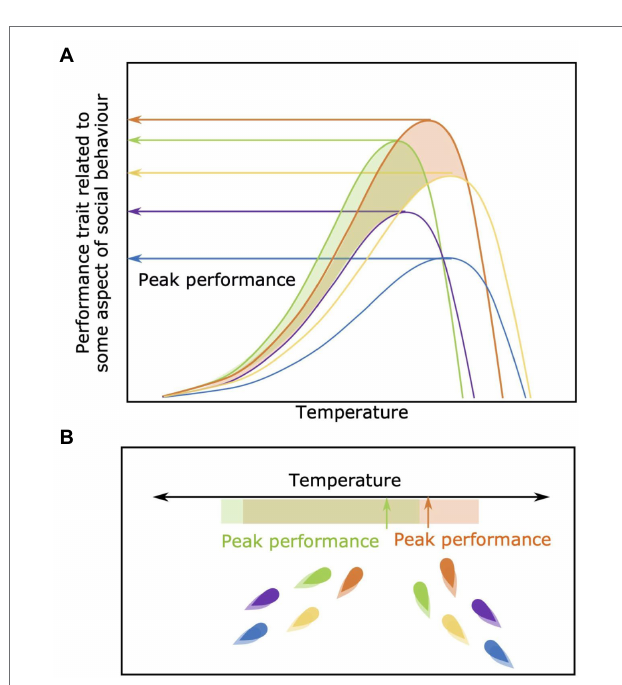
FIGURE 6 | Among-individual differences in peak performance regardless of optima. In panel (A) individuals show variation in their absolute performance capacity across temperatures. In panel (B) individuals green and orange have a higher peak performance compared to the other individuals within the group, regardless of the optimal temperature for each. This elevated peak allows these two individuals to have a higher relative capacity for performance even if they are deviating from their own specific optimal